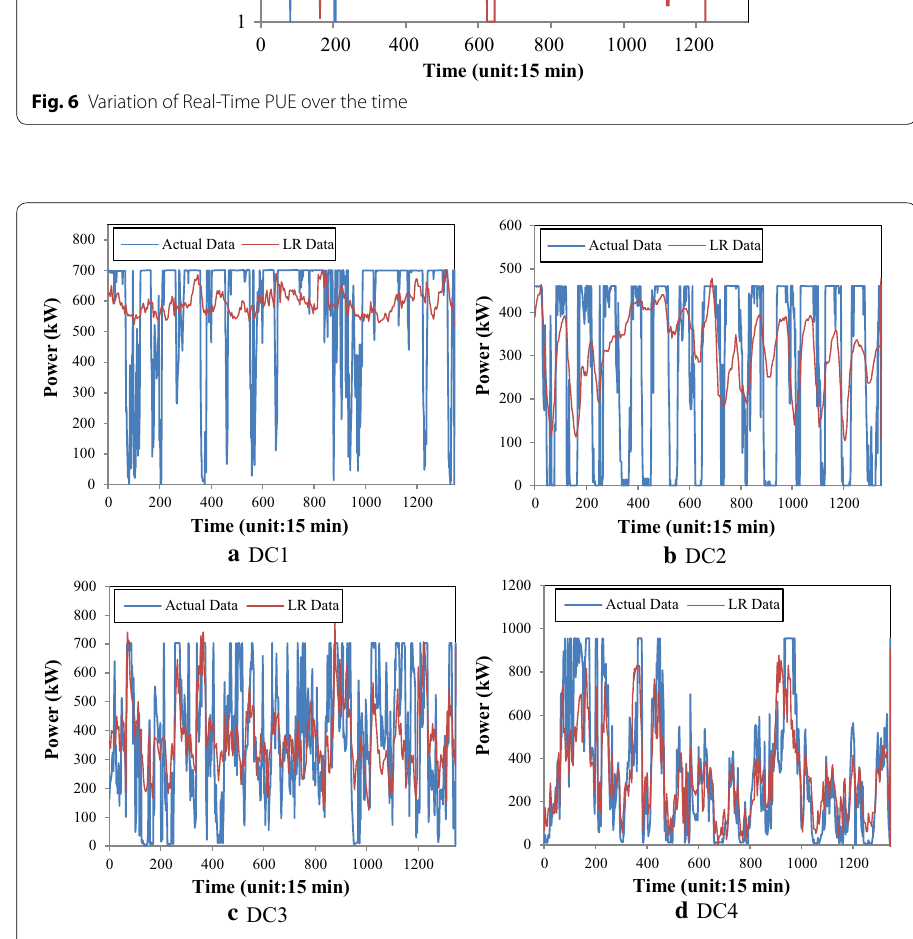
Fig. 7 Comparison of the best-fitted LR model with the actual power